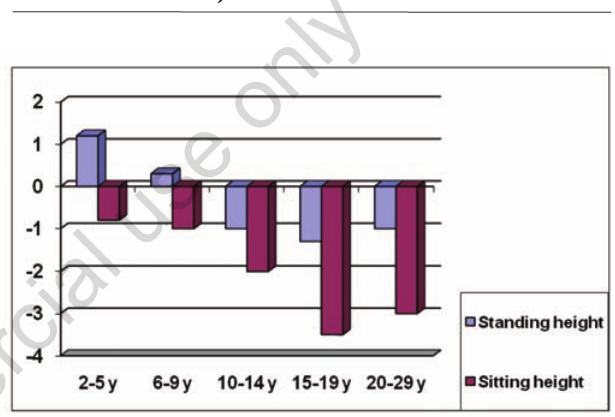
Figure 2. Standing height and sitting height is SDS in different